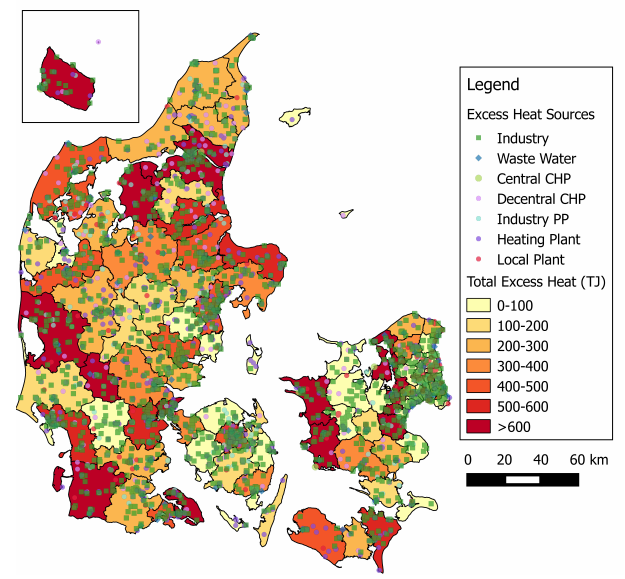
Figure 3. Map of Denmark with the location and type of excess heat sources and the total sum of excess heat of each region.